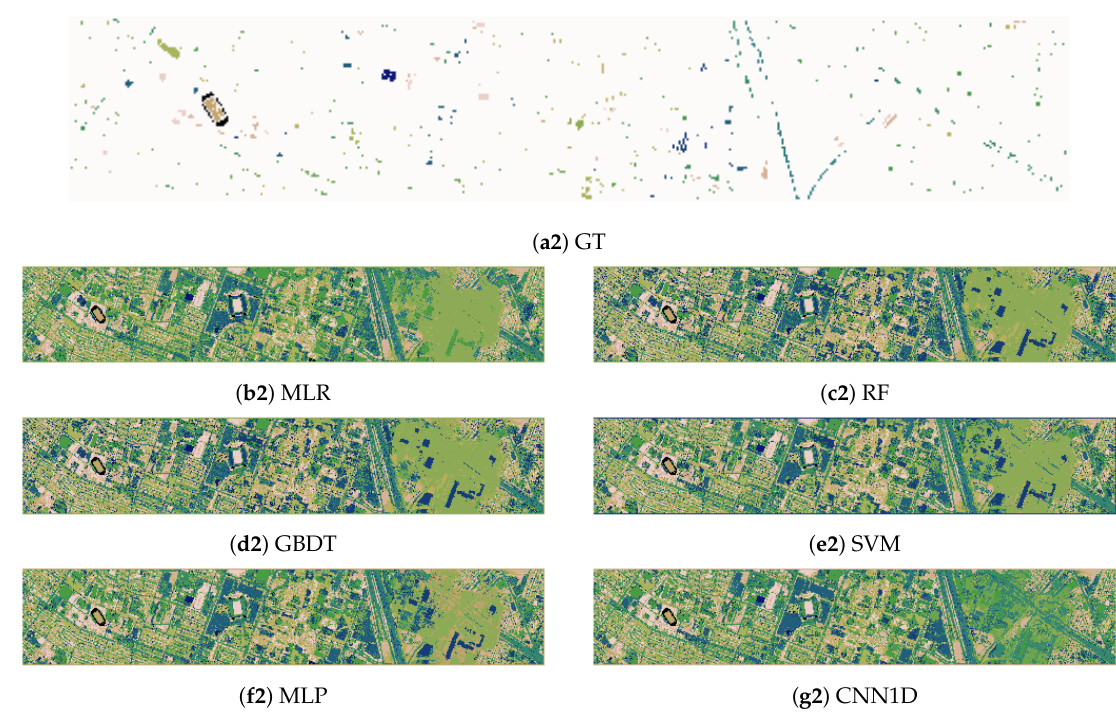
Figure 4. Classification maps obtained for the considered data sets by the different models: ( a1 , a2 ) Ground truth, ( b1 , b2 ) MLR, ( c1 , c2 ) RF, ( d1 , d2 ) GBDT, ( e1 , e2 ) SVM, ( f1 , f2 ) MLP and ( g1 , g2 )